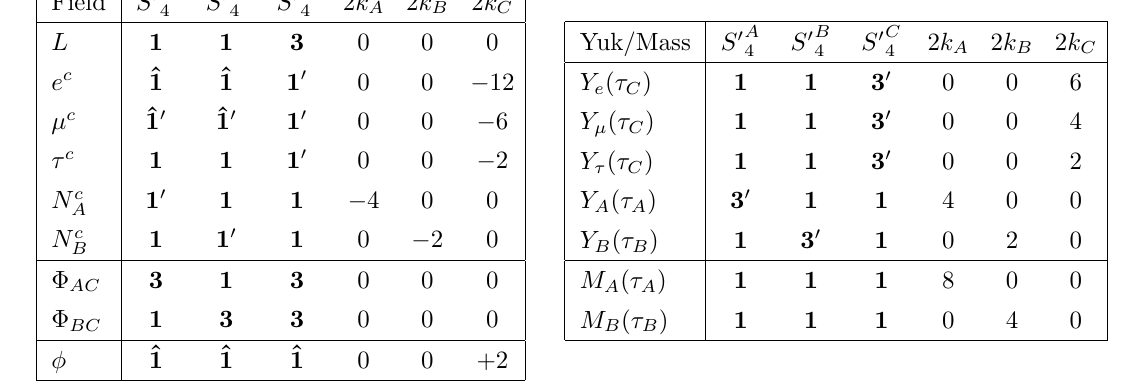
Table 6 . Assignments of fields for the weighton version of the model.